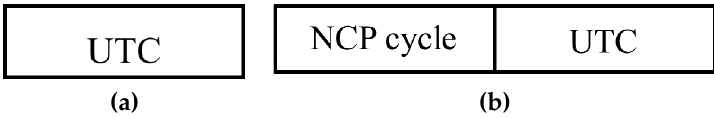
Figure 11. Addition of an NCP cycle in the data transmission structure after receiving an ADD command from the Sink Node. ( a ) Before receiving ADD command packet; ( b ) After receiving ADD command packet.